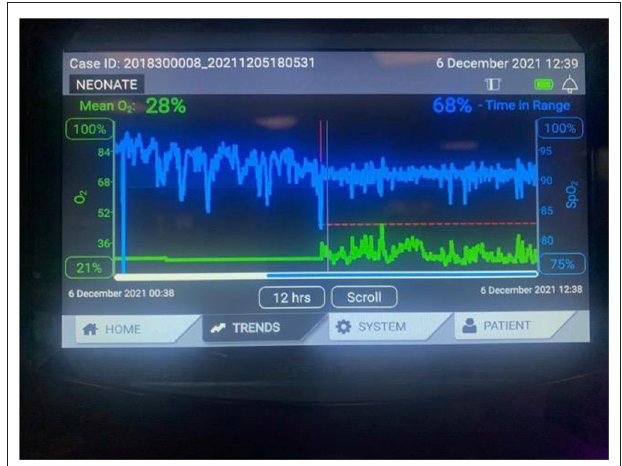
FIGURE 2 | Oxygen assist module in Vapotherm Precision Flow